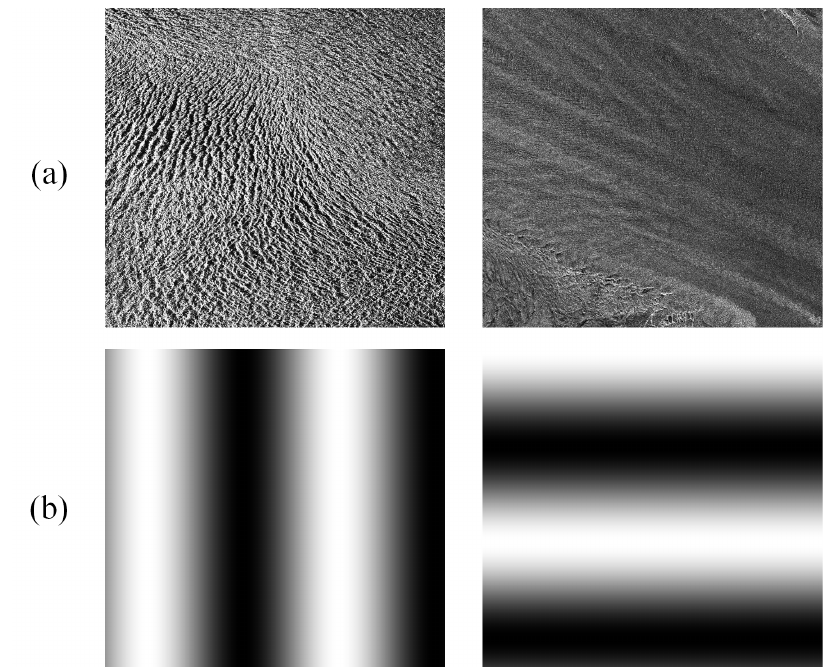
Figure 4. ( a ) TSX and S1A image subsets used to generate synthetic image pairs; ( b ) sinusoidal deformations in two